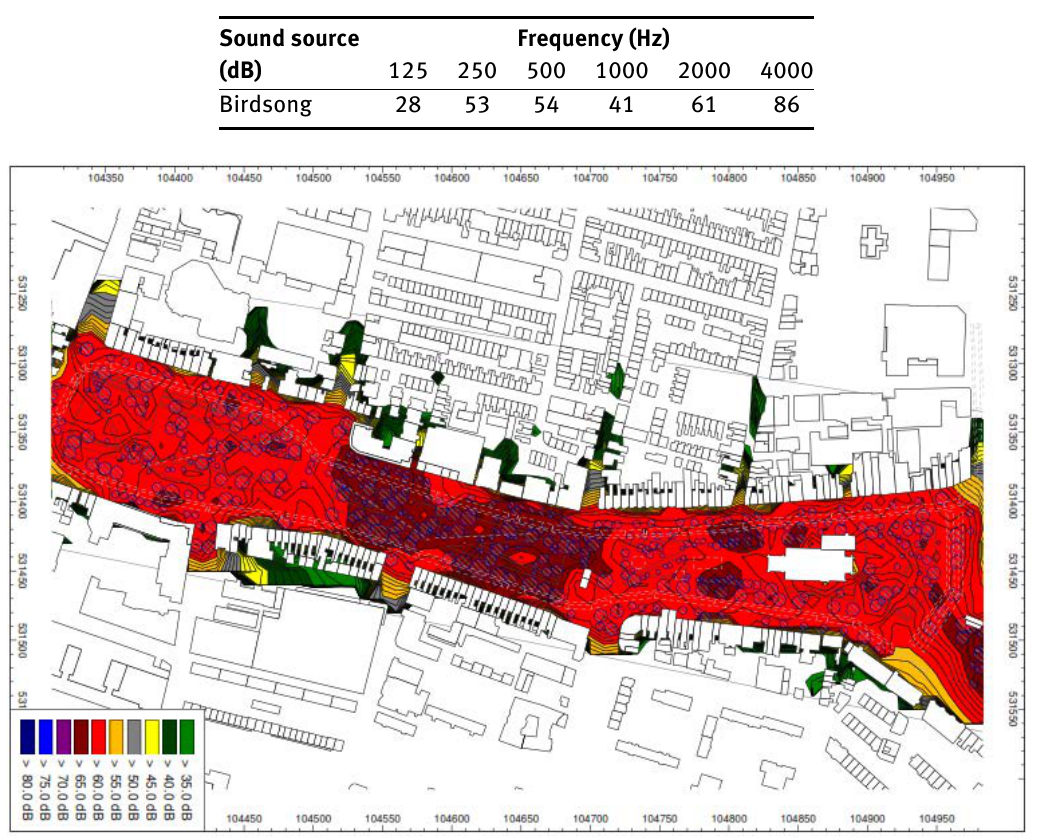
Figure 5: Sound map calculated for birdsong sound sources’ spatial distribution (L day )